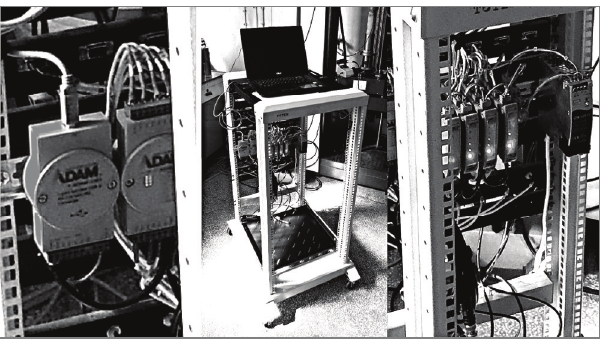
Fig. 6. Multi-channel measuring equipment